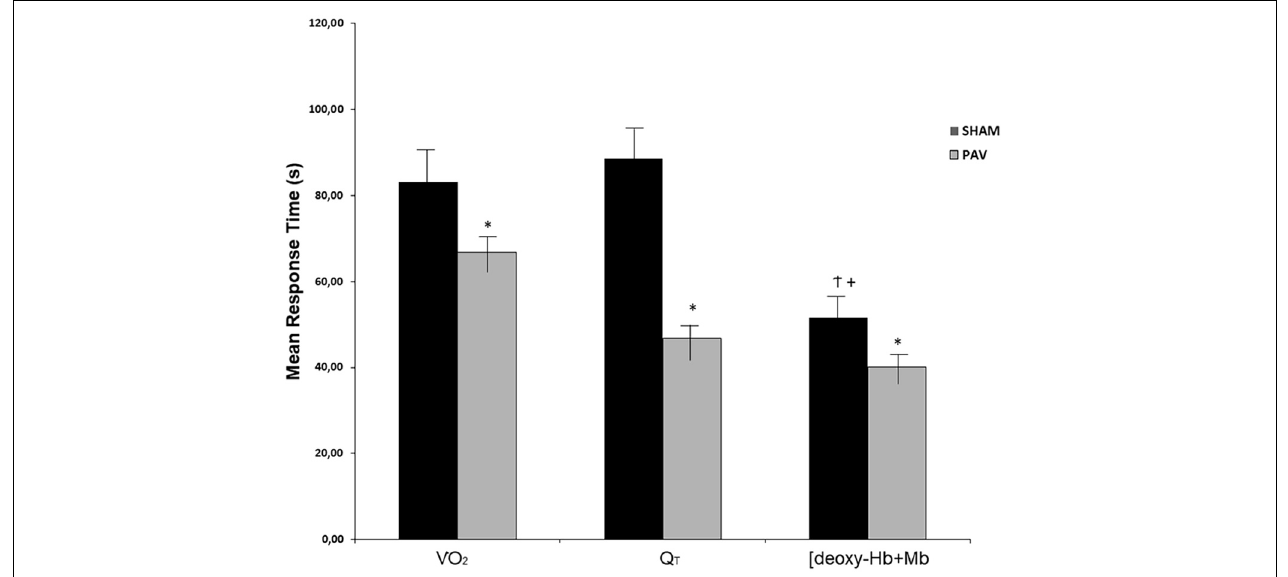
FIGURE 2 | Mean response time (MRT) of ˙VO 2 p , Q T , and deoxy-hemoglobin concentration ([deoxy-Hb + Mb]), on recovery of heavy-intensity exercise during Sham (open bars) and PAV (solid bars). Note that the dynamics of ˙VO 2 p and Q T and [deoxy-Hb + Mb] recovery were faster during PAV ( p < 0.05). In addition, [deoxy-Hb + Mb] kinetic was faster than QT and ˙VO 2 p only when Sham was administered in HFrEF patients. Values are means (SD). ∗ p < 0.05 for between-intervention comparisons; † p < 0.05 for within-variables comparisons between [deoxy-Hb + Mb] vs. ˙VO 2 p ; and + p < 0.05 for within-group comparisons of [deoxy-Hb + Mb] vs. Q T .